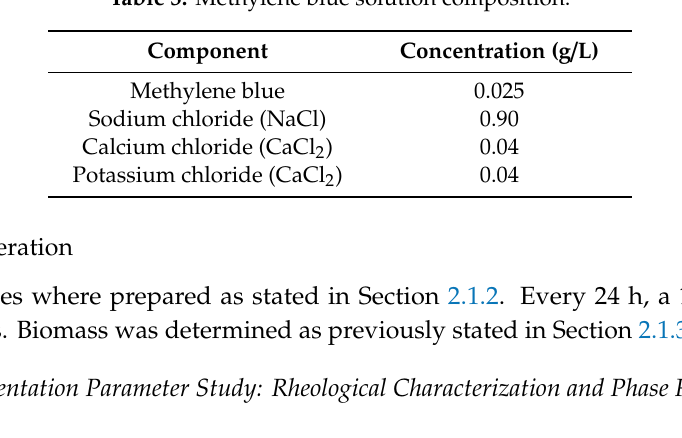
Table 3. Methylene blue solution